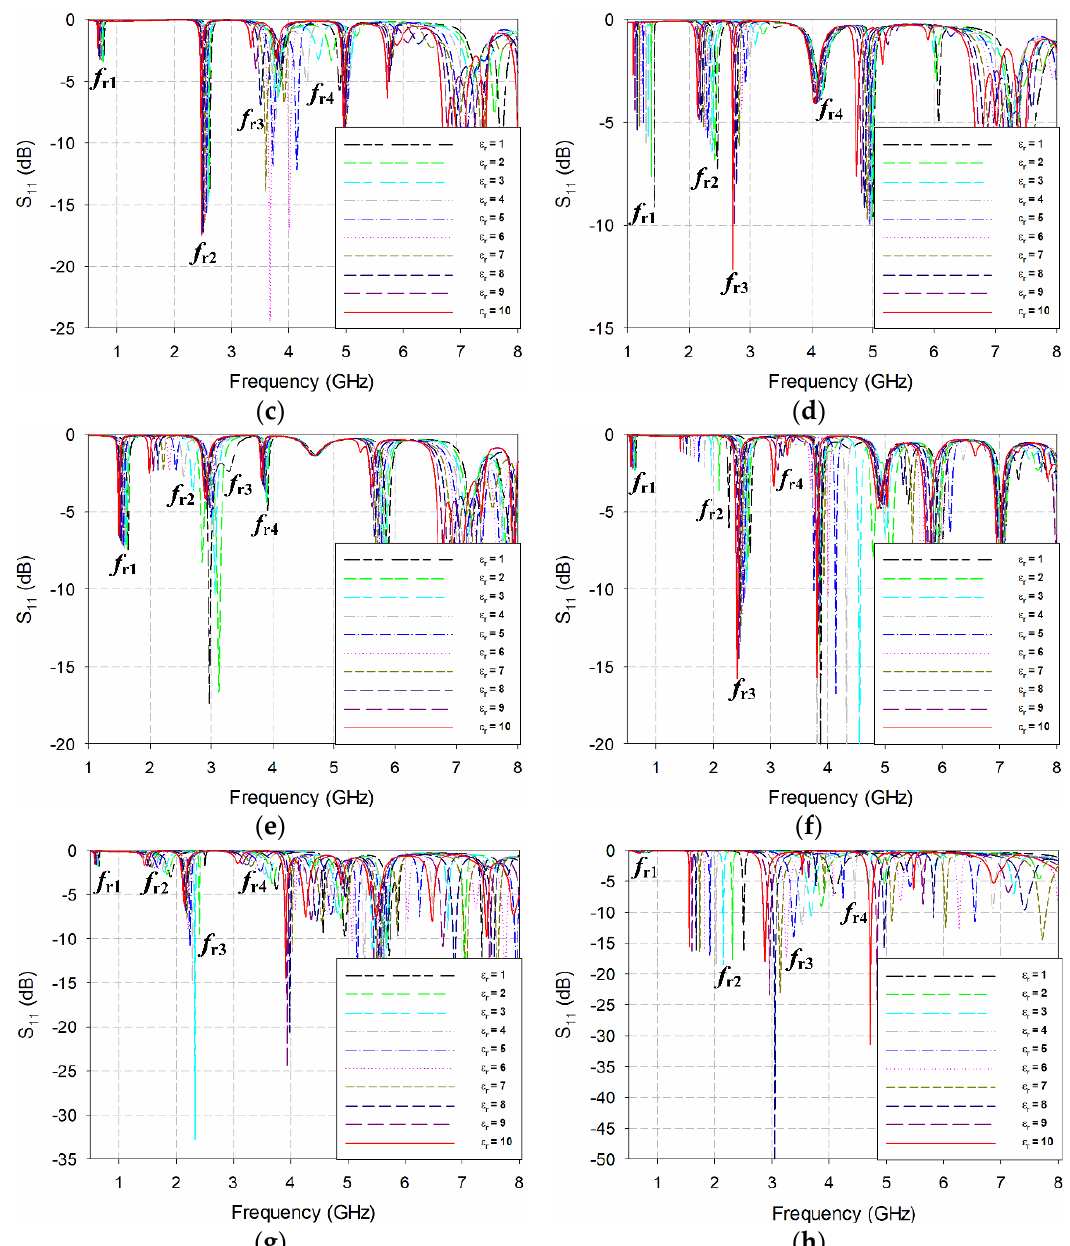
Figure 3. S 11 characteristics when varying the relative permittivity of the MUT from 1 to 10 for: ( a ) the conventional MPSA without a DGS; ( b ) the RS DGS-loaded MPSA; ( c ) the SR-CSRR-OS DGS-loaded MPSA; ( d ) the SR-CSRR-IS DGS-loaded MPSA; ( e ) the R-SR-CSRR DGS-loaded MPSA; ( f ) the DR-CSRR-RA DGS-loaded MPSA; ( g ) the DR-CSRR-CA DGS-loaded MPSA; and ( h ) the proposed scaled DR-CSRR DGS-loaded